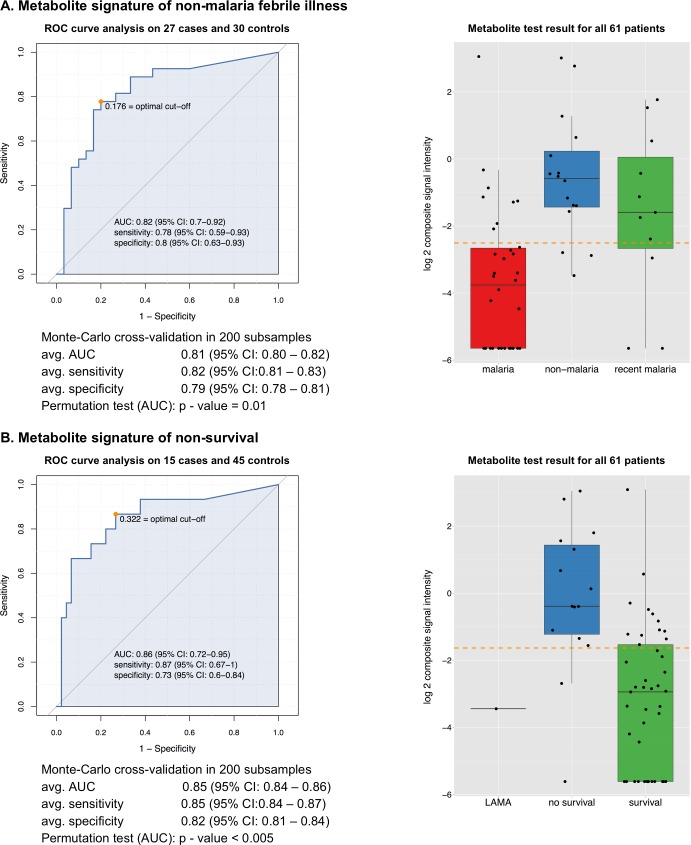
Diagnostic performance of corticosteroid signature for non-malaria febrile illness (panel A) and non-survival (panel B).The metabolite signature consists of 2 corticosteroid compounds detected by C18-UHPLC-MS: a C21-corticosteroid (ID_2094_ON, m/z M-H = 377.196, putative ID: C21H30O6 18-hydroxycortisol) and a C19-steroid-glucuronide (ID_3388_ON, m/z M-H = 481.243, putative ID: C25H38O9 11-beta-hydroxyandrosterone-3-glucuronide). Each panel shows: (i) a ROC curve along with the optimal cut-off value (the non-malaria analysis excluded BSI/malaria co-infection patients; the non-survival analysis excluded patients that left hospital against medical advice), (ii) check for over-fitting by Monte-Carlo cross-validation based on 200 rounds of balanced subsampling in all cases and controls and the significance permutation test, and (iii) a boxplot with the test result for all 61 patients (x-axis categories indicate the patient groups based on the study case definitions, y-axis shows the test-value of the diagnostic test which is based on the sum of the signal intensity of the two metabolites, here called composite signal intensity, included in each model, the orange dashed line indicates the cut-off value determined in the ROC analysis). (Abbreviations: LAMA = left against medical advice)